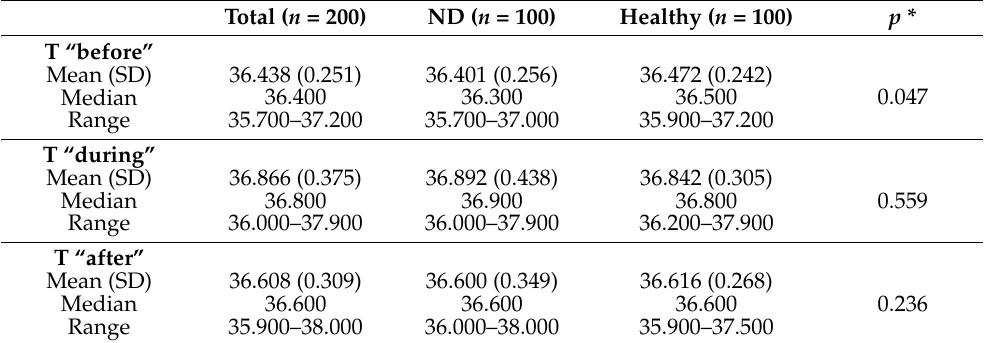
Table 2. Differences in the forehead temperature values between the children with neurodevelop- mental disorders (ND) and the healthy children